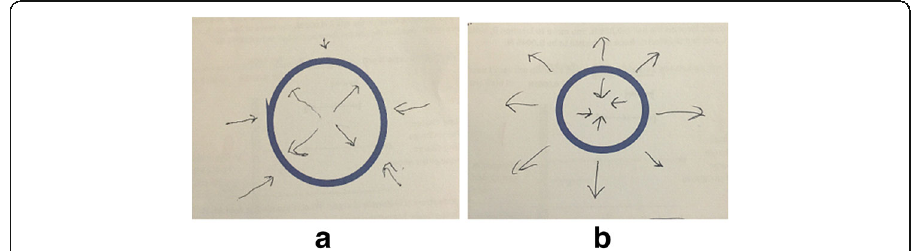
Fig. 9 Sample of a student's response from an incorrect understanding to a correct understanding. a Pre-test. b